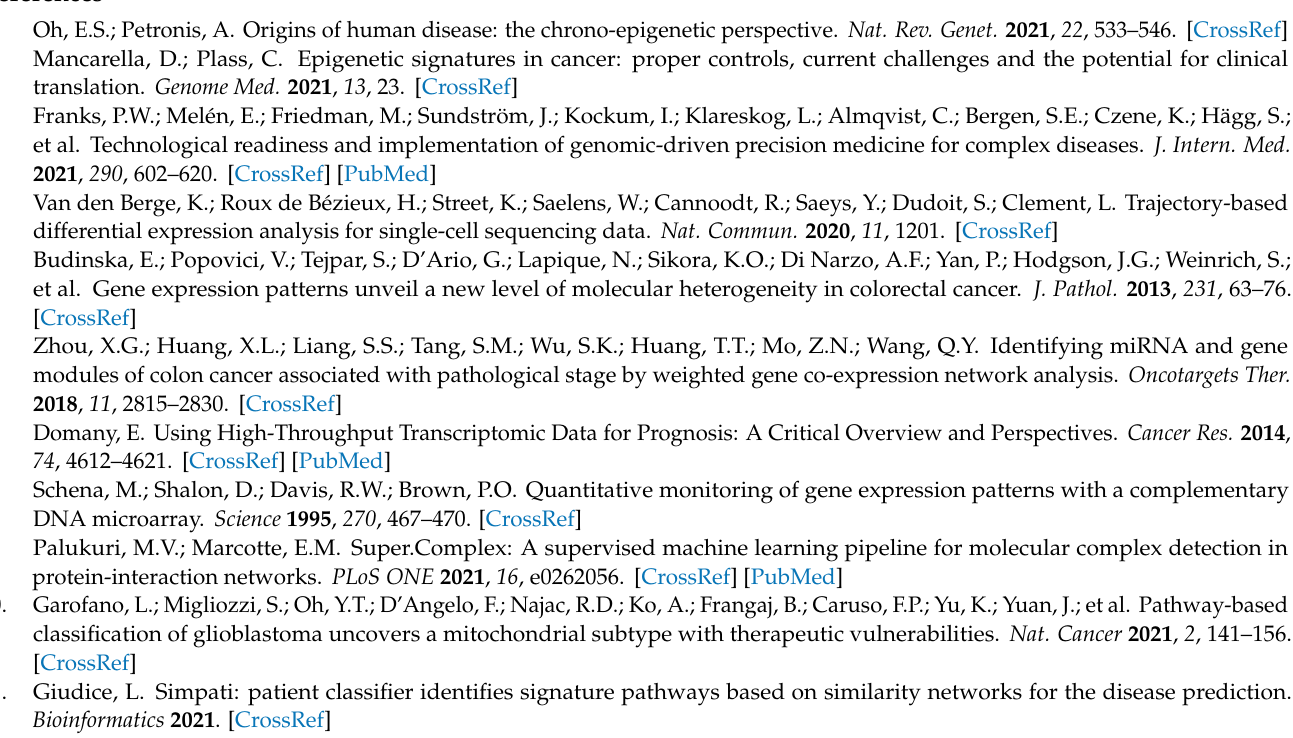
for Pathway Activity Inference Methods; Figure S2: tSNE dimension reduction scatters plots and Hierarchical clustering map of significant pathways in COAD; Figure S3: Computational efficiency Comparison between DIGS and DIOPTRA; Figure S4: Protein-protein interaction network for pan- creatic secretion and chemical carcinogenesis; Figure S5: Top 30 pathway from SHAP for BRCA and COAD; Figure S6: Top 10 pathways from SHAP for each subtype of BRCA; Figure S7: Top 10 pathways from SHAP for each subtype of COAD; Table S1: Classification Metrics Comparison of RF and KNN for Pathway Activity Inference Methods; Table S2: The ranking of all pathways and genes for BRCA and COAD. All authors have read and agreed to the published version of the